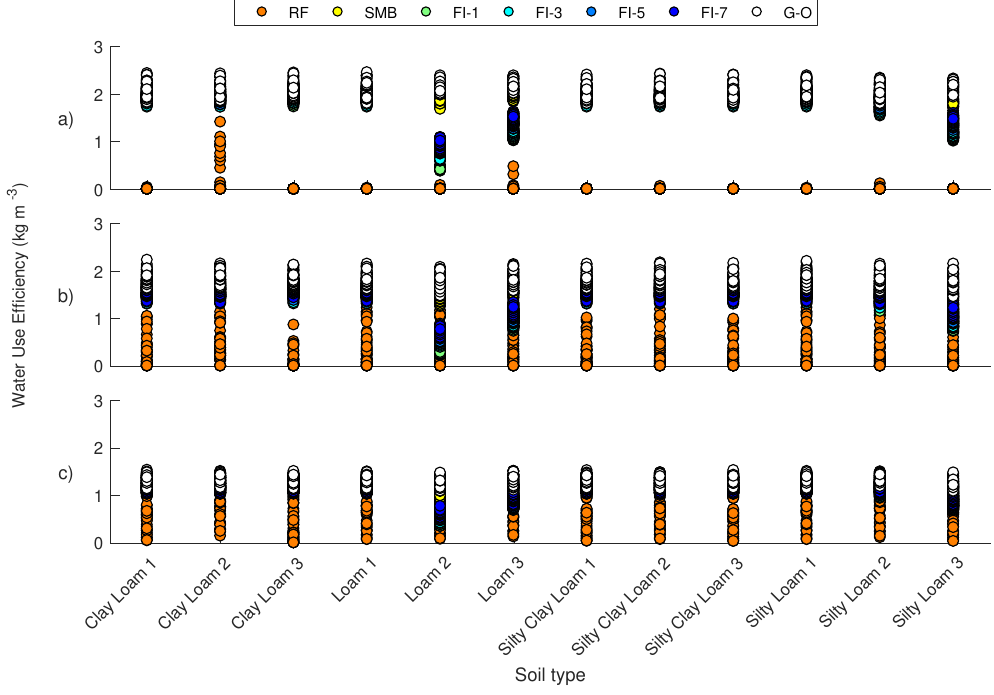
Figure 8. Water-use efficiency (WUE) for maize ( a ), sugar beet ( b ), and wheat ( c ) as a function of soils with low (1), medium (2), and high (3) bulk densities under different irrigation strategies: RF: Rainfed; SMB: Soil moisture-based; FI: Fixed interval every 1, 3, 5, and 7 days; and G-O: GET-OPTIS considering simulated values from 1965 to